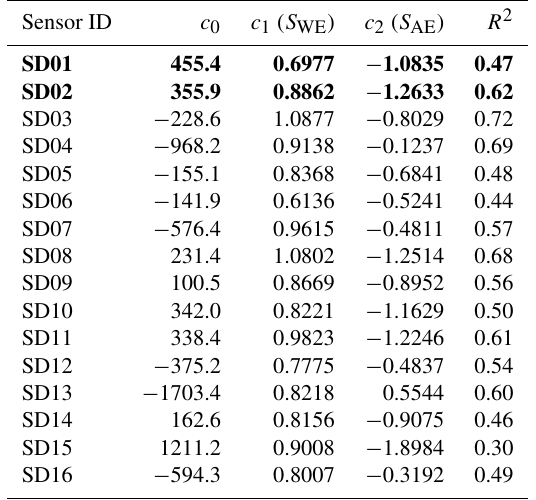
Table 1. Fit results for regression model A. Older NO2-B42F sen- sors highlighted in